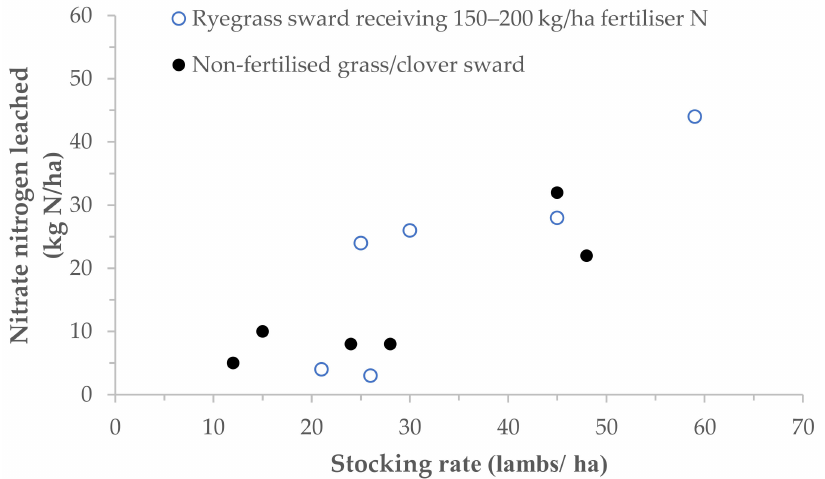
Figure 3. Relationship between quantities of annual nitrate nitrogen (N) leached and mean stocking rates (post-weaning) for a ryegrass sward receiving 150 to 200 kg/ha fertiliser N (open symbols) and a non-fertilised grass/clover sward (solid symbols): 1987–1993 (Cuttle et al. [37]; Adapted from Cuttle and Scholefield